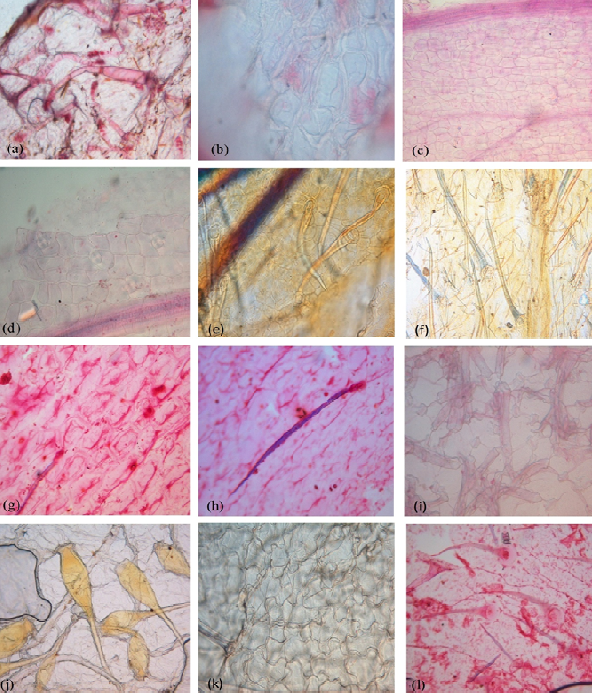
Fig. 5. a Cicer microphyllum (Trichomes); b . Cicer microphyllum (Cells and Stomata); c. Silene edgeworthii (Cells); d. Silene edgeworthii (Stomata); e. Arnebia euchroma (Trichomes); f. Arnebia euchroma (Cell and Trichomes ) ; g . Melilotus officinalis (Cells); h. Melilotus officinalis (Trichome); i. Selinum tenuifolium ; j. Delphinium brunonianum (Trichomes ) ; k . Delphinium brunonianum (Cells); l . Lindelofia stylosa